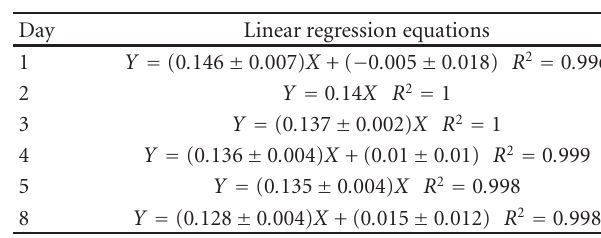
Table 2: Linear regression results for stability of H 2 O 2 standard solutions at room temperature.